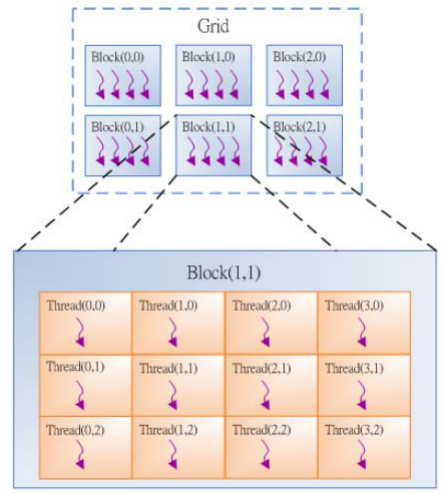
Fig. 1. The parallelism architecture of